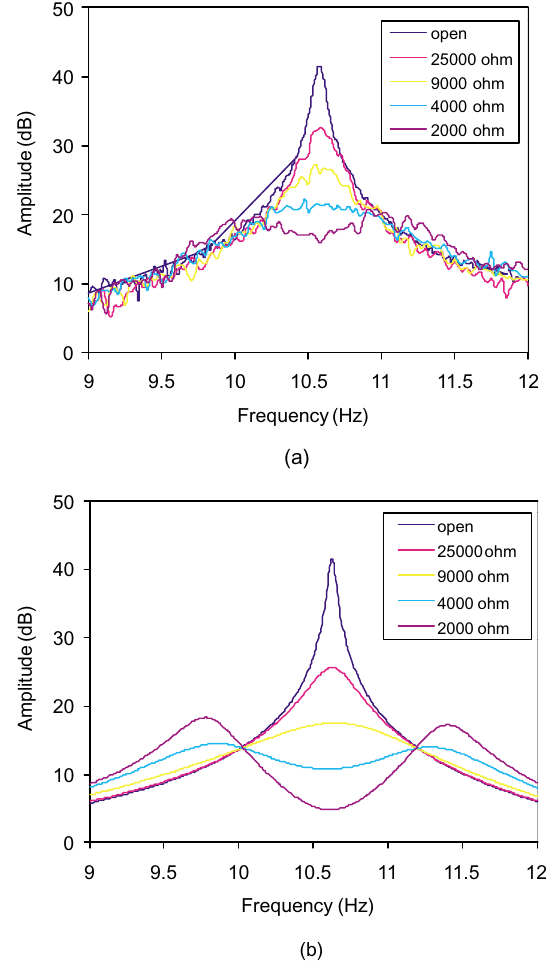
Fig. 8. Frequency response curve with half inductance (445H): (a) experiment and (b) theory. branch circuit. By the calculation, 890 Henry was re- quired to control the first mode vibration